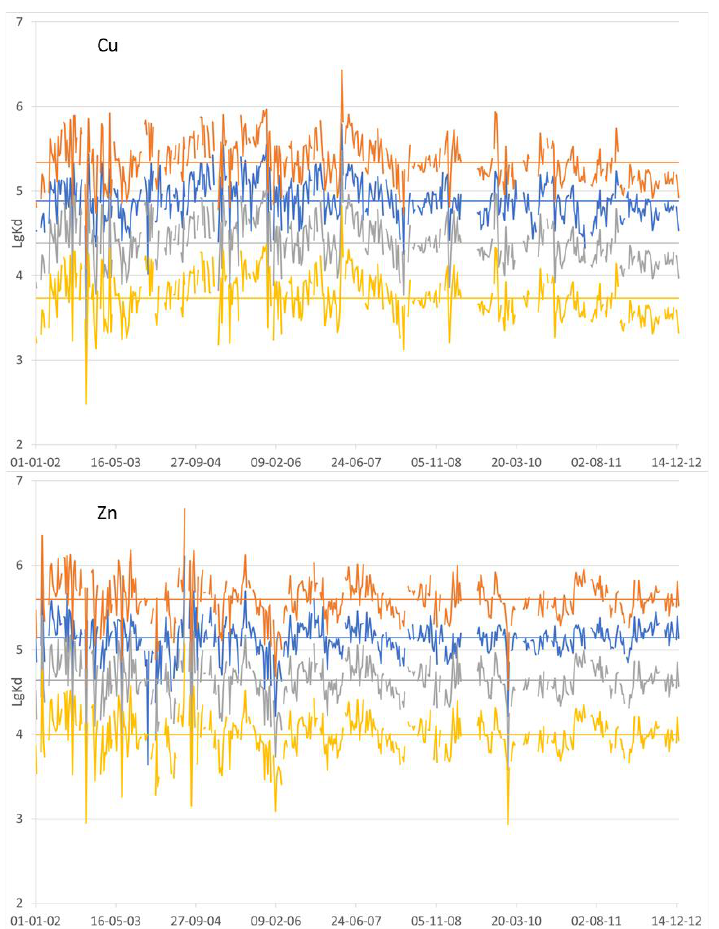
Figure 8. Partitioning coefficients (lgKd) of copper (upper graph) and zinc (lower graph) at Eijsden (Meuse). The blue line indicates the lgKd calculated for total SS, the orange line indicates the lgKd calculated for clays, the grey line indicates the lgKd calculated for fine silts, the yellow line indicates the lgKd calculated for coarse silts. The horizontal lines correspond to the median of lgKd for each class of particles.